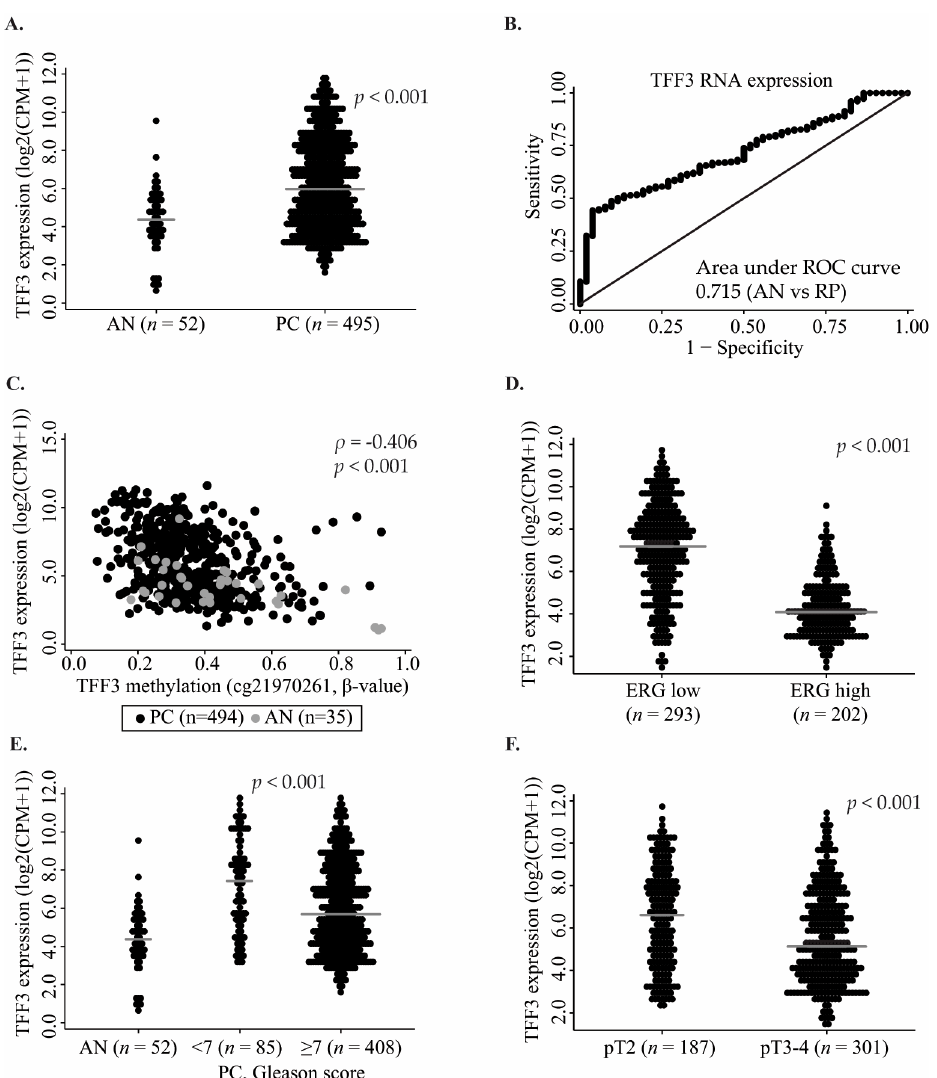
Figure 2. Transcriptional TFF3 expression based on RNAseq data from TCGA. ( A ) TFF3 RNA expression in AN ( n = 52) and PC ( n = 495) tissue samples; ( B ) ROC curve analysis for TFF3 RNA expression in AN vs. PC samples; ( C ) Correlation between TFF3 promoter methylation (cg21970261; CpG site No. 4) and TFF3 RNA expression in AN ( n = 35, grey) and PC ( n = 494, black) samples from TCGA. Correlations between TFF3 RNA expression and ( D ) ERG RNA expression ( n = 495), ( E ) Gleason score ( n = 493), and ( F ) pathological T-stage ( n = 488). Abbreviations: CPM, counts per million; AN, adjacent normal; PC, prostate cancer; p , p -value (Mann–Whitney U test or Spearman’s correlation test); ρ , Spearman’s rho; pT, pathological T-stage; Grey line, median expression.